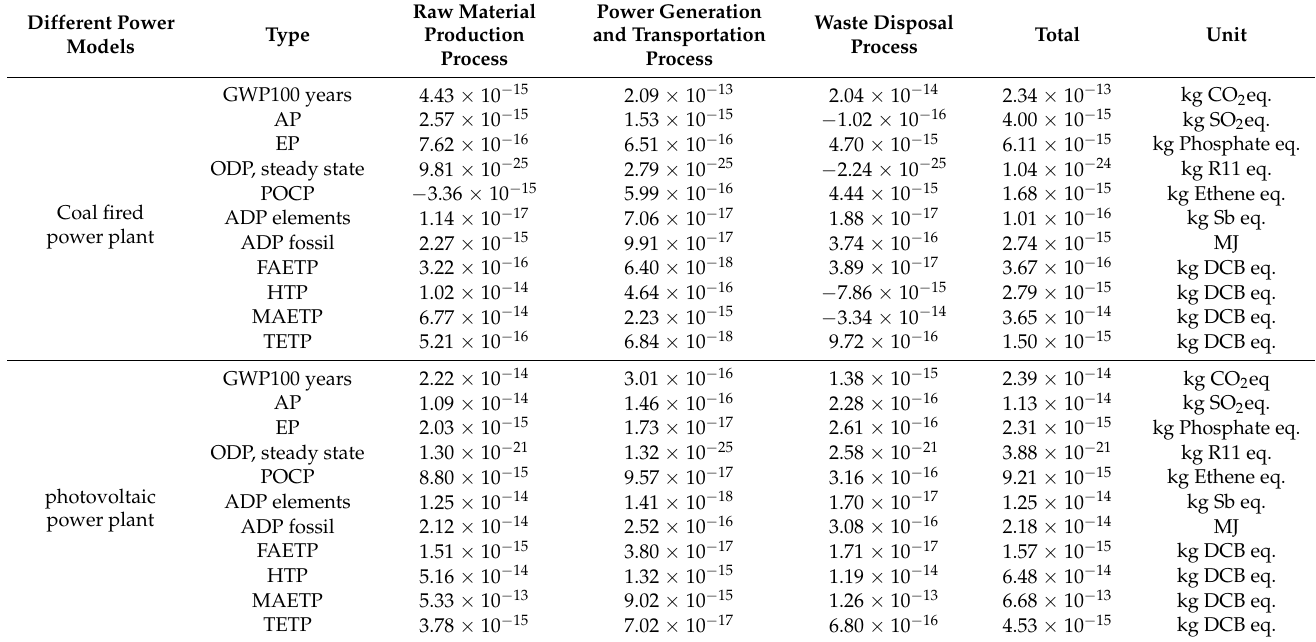
Table 6. LCA standardization values of coal-fired power plants and photovoltaic power